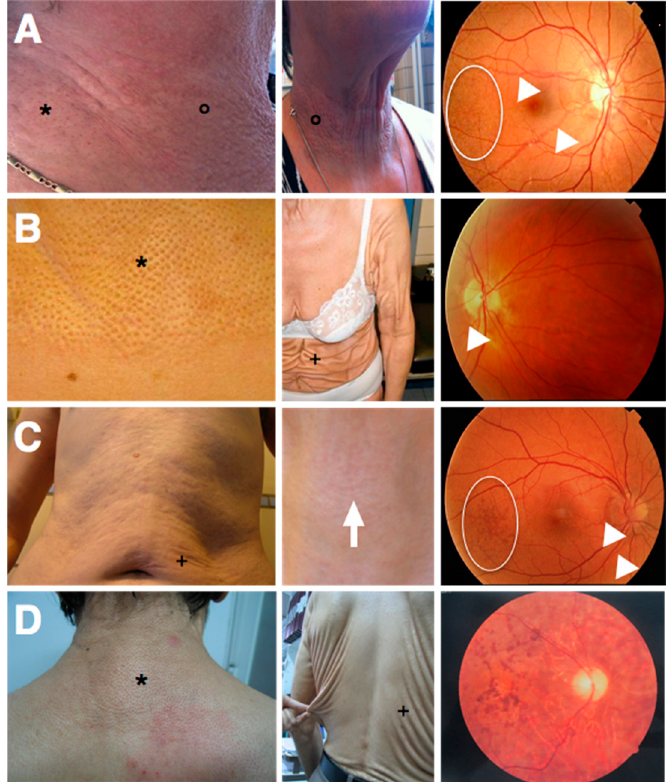
Figure 3. Skin and eye symptoms of the known gamma-glutamyl carboxylase (GGCX)-related disease entities. In each panel, two photos depict different aspects of the respective skin phenotypes (left and middle), the right image shows a fundus typical for the disease entity: ( A ) PXE; ( B ) PXE-like disorder with combined coagulation factor deficiency; ( C ) patient with PXE/PXE-like overlap; and ( D ) PXE-like syndrome with pigmentary retinopathy. *: yellowish skin papules, °: skin plaques; arrowheads: angioid streaks; spherical diagram: peau d’orange; +: skin loosening and excessive skin folds; arrow: reticular rash; PXE: pseudoxanthoma elasticum; PXE-like: PXE-like disorder with combined coagulation factor deficiency.